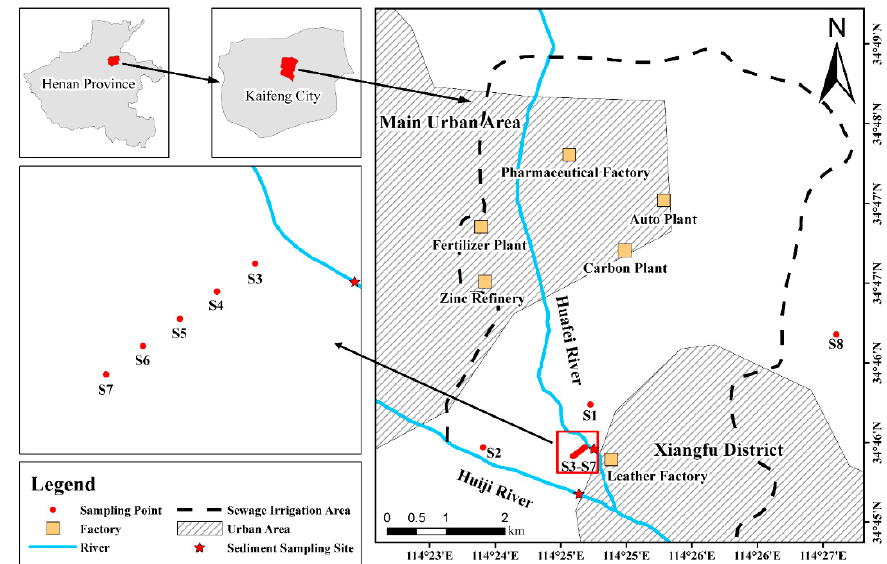
Figure 1. Positions of sampling points.